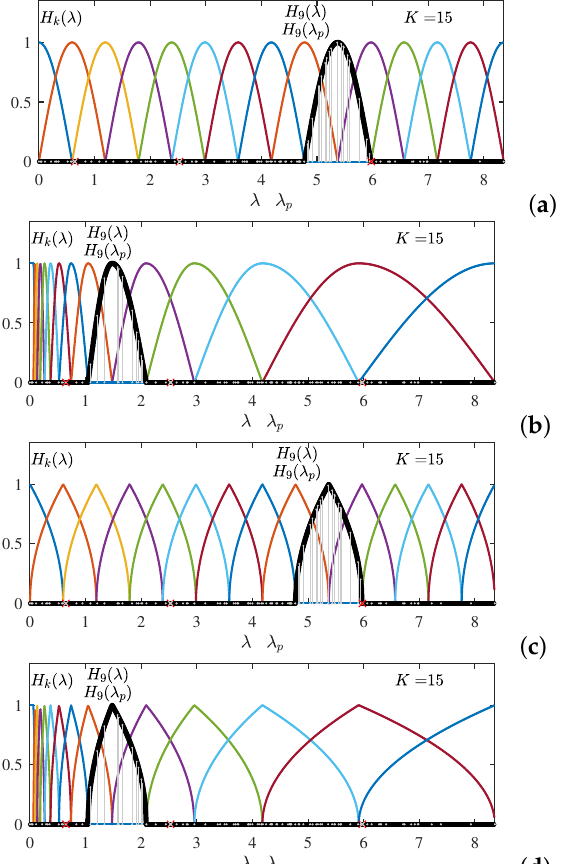
Figure 12. Transfer functions formed using the Hann window ( a , b ) and the Bartlett window ( c , d ) square root so that the reconstruction condition ∑ K − 1 ( a , c ) of the spectral domain and a wavelet-like splitting ( b , d